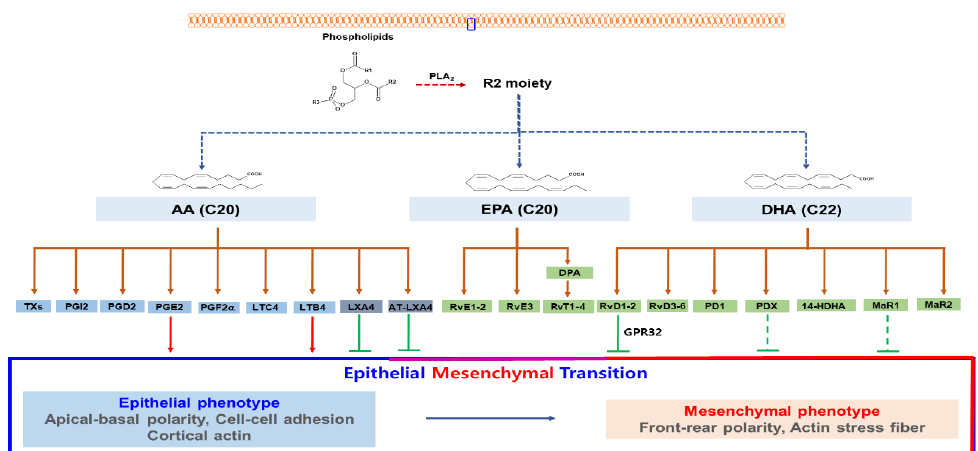
Figure 2. Inflammatory contribution to EMT. PGE2 and LTB4 produced from arachidonic acid can induce EMT in epithelial cancer cells. In contrast, LxA4 and AT-LxA4 from arachidonic acid can repress EMT in cancer cells. RvD1, RvD2, PDX, and MaR1 from DHA can suppress EMT in cancer